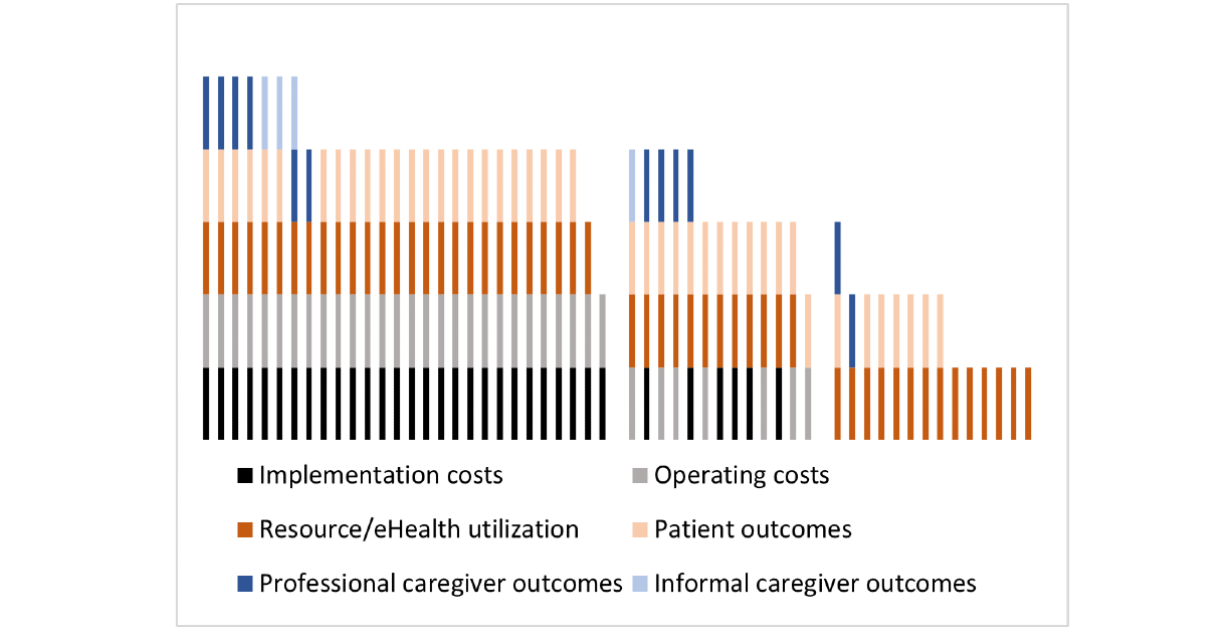
Figure 2. Level of integration in 55 included studies (represented as